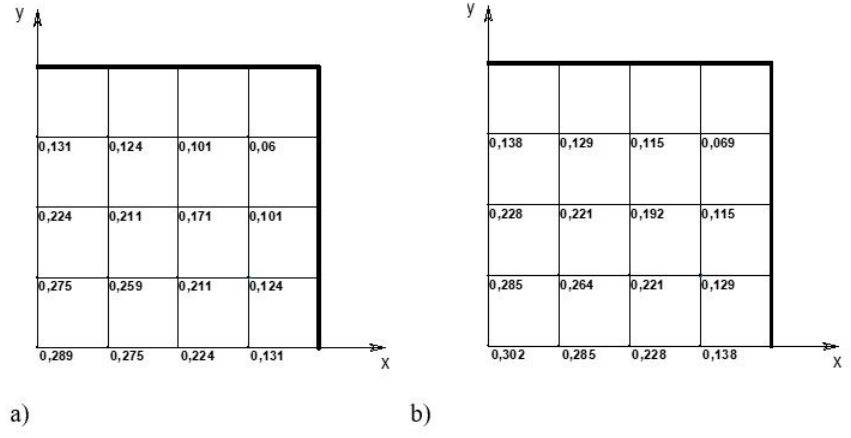
Figure 3: Shell deflections (cm): a) according to a linear scheme; b) according to a nonlinear scheme